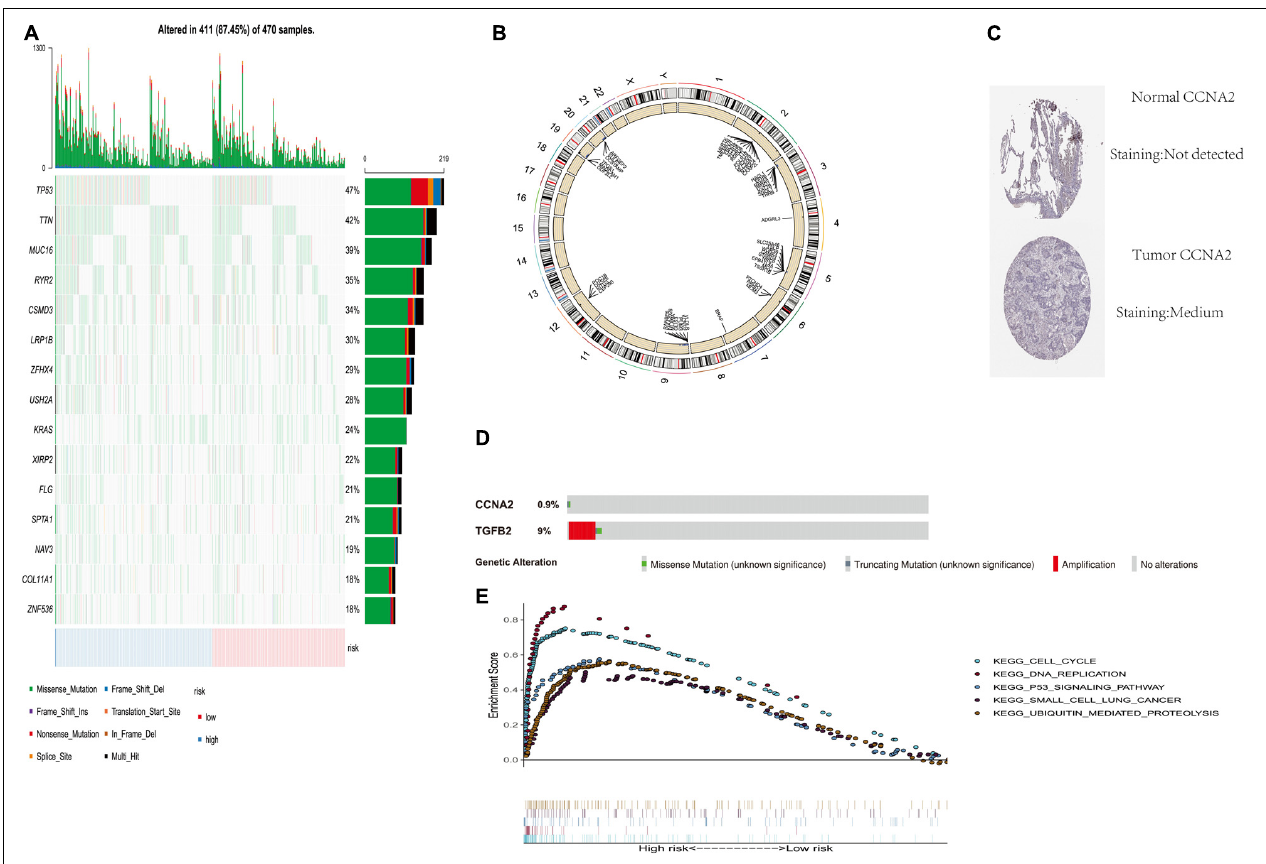
FIGURE 5 | Genome-wide analysis of two PM-related genes risk scores (including mutation and copy number change). (A) Distribution of the first 15 mutant genes in high and low risk groups; (B) differential copy number in nine CLEC-2-related gene risk score high and low groups; (C) immunohistochemical results for risk score components in the HPA database; (D) mutation rate of TGFB2 and CCNA2 in the CBioportal database; (E) GSEA was performed among TCGA high-risk populations. PM, platelet and immunity; TCGA, Cancer Genome Atlas Dataset.